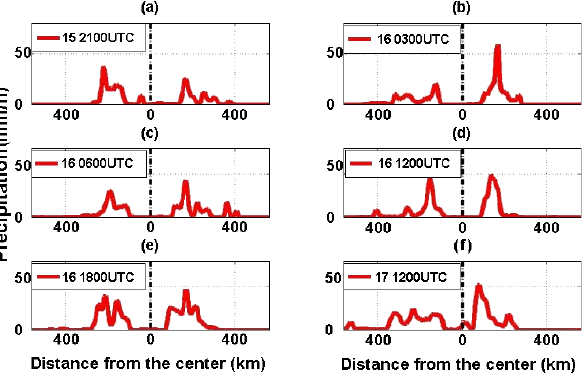
Fig. 14. Longitudinal precipitation cross section at the centre of TC Ivan on 15 February 2008 at 21:00UTC (a) ; 16 February at 03:00UTC (b) , 06:00UTC (c) , 12:00UTC (d) , and 18:00UTC (e) ; and 17 February at 12:00UTC (f) .